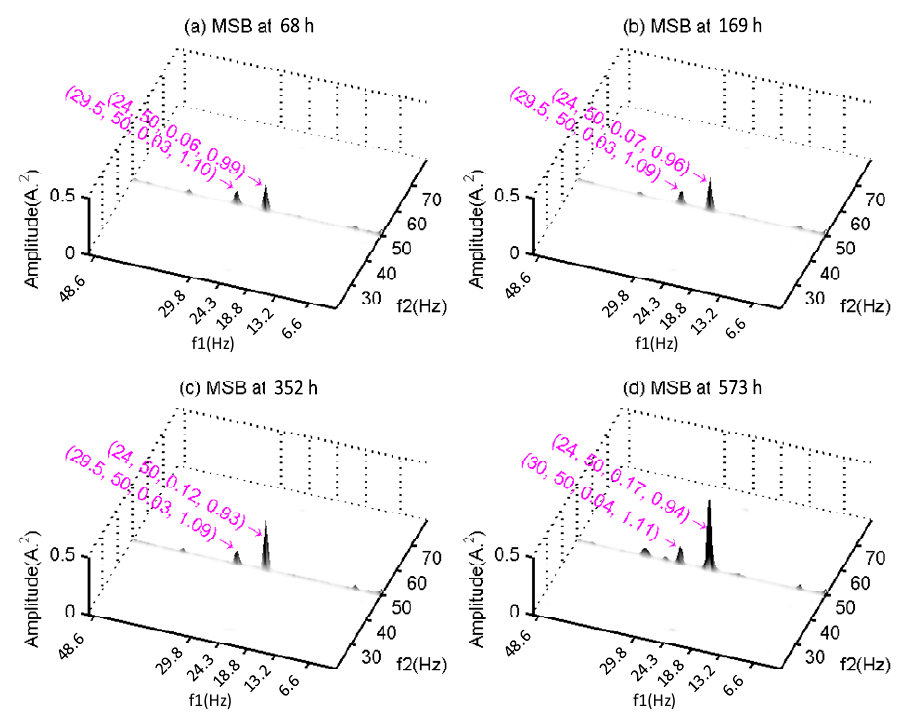
Figure 8. MSB amplitudes for gearbox deterioration at successive time instants.